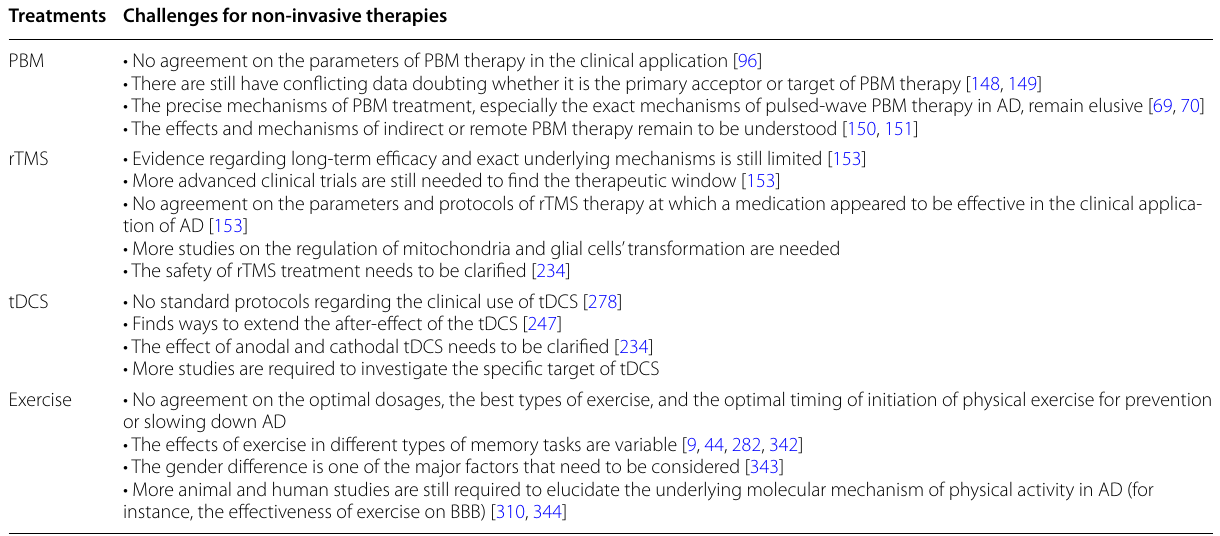
PBM Photobiomodulation, rTMS Transcranial magnetic stimulation, tDCS Transcranial direct current stimulation